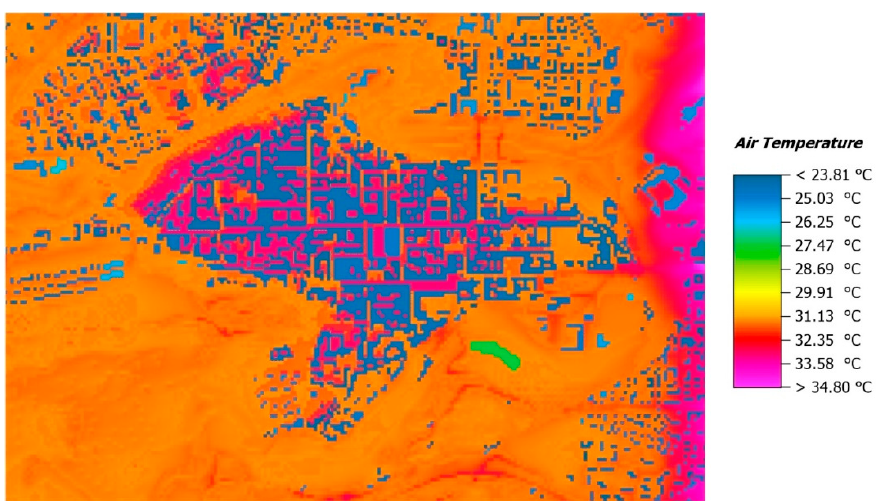
Figure 2. Urban heat island (UHI) in the city of Ascoli Piceno.